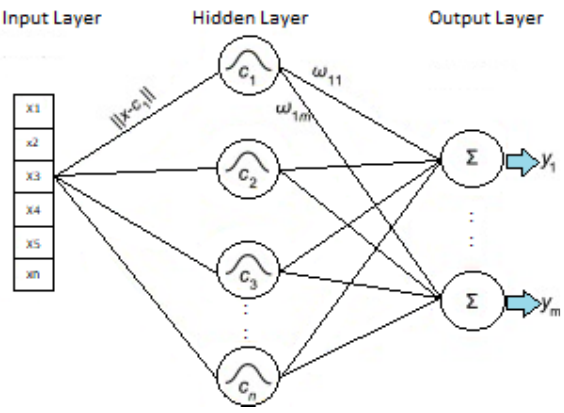
Figure 2. RBF network structure (Source: Faris et al.